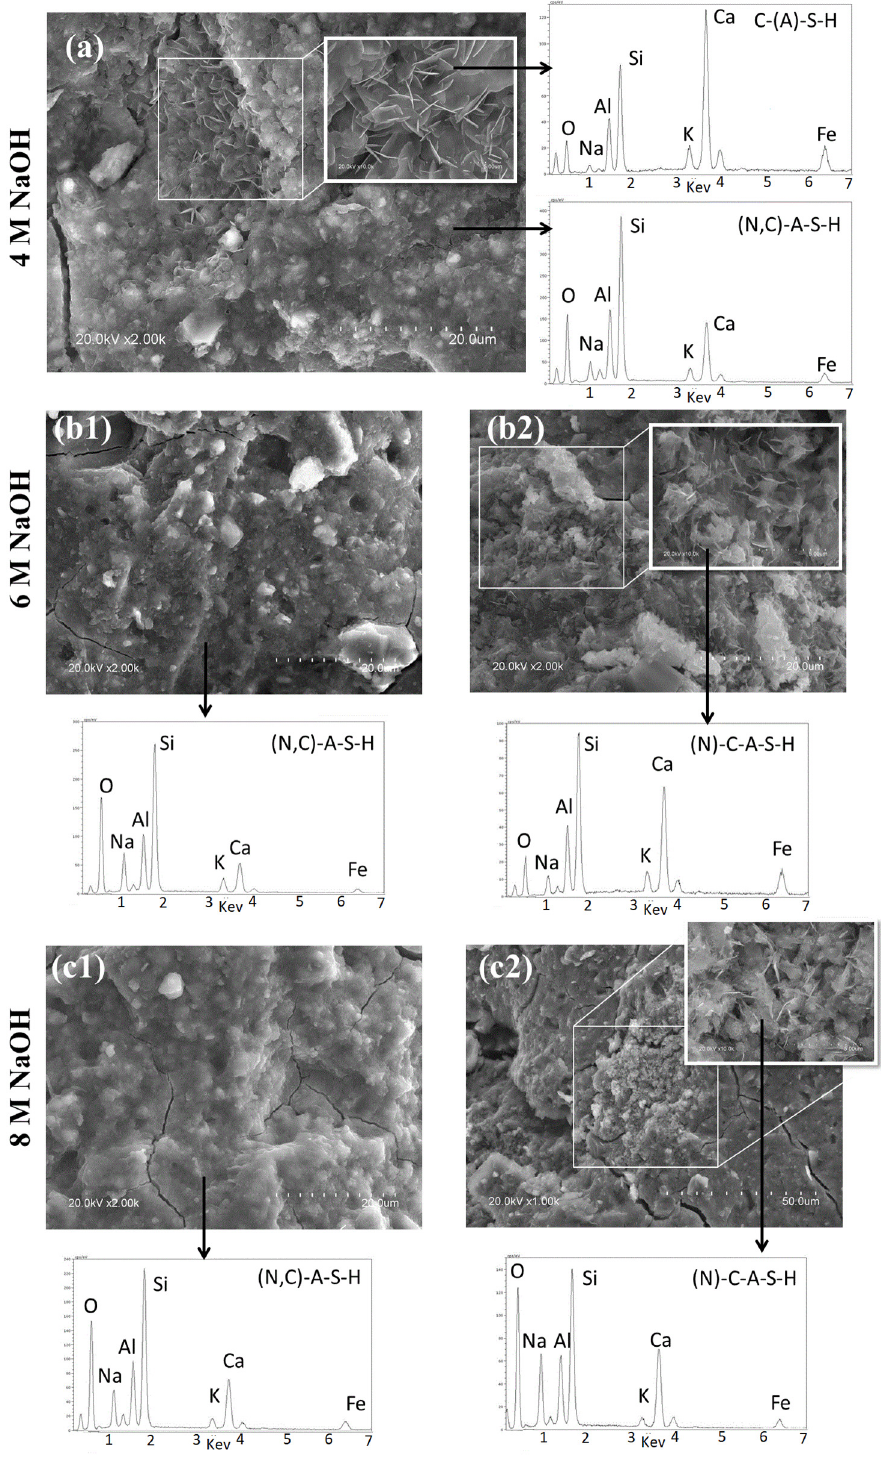
Figure 5. Two day SEM micrographs and EDX spectra for ( a ) 4 M, ( b ) 6 M ( b1 , b2 ) and ( c ) 8 M ( c1 , c2 ) NaOH-activated pastes.